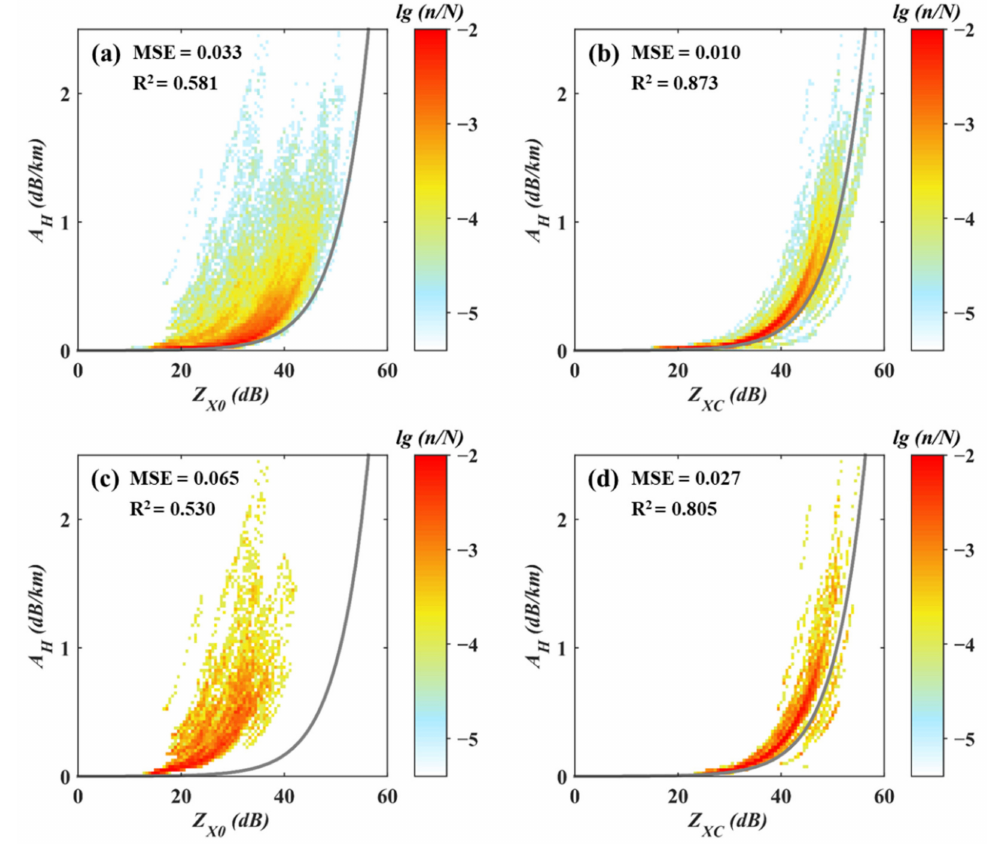
Figure 10. Frequency plots of Z H , and A H before ( a ) and after ( b ) attenuation correction at 01:50 and frequency plots of gates with ϕ DP > 40 ◦ before ( c ) and after ( d ) attenuation correction, where the gray curve is the fitting results of